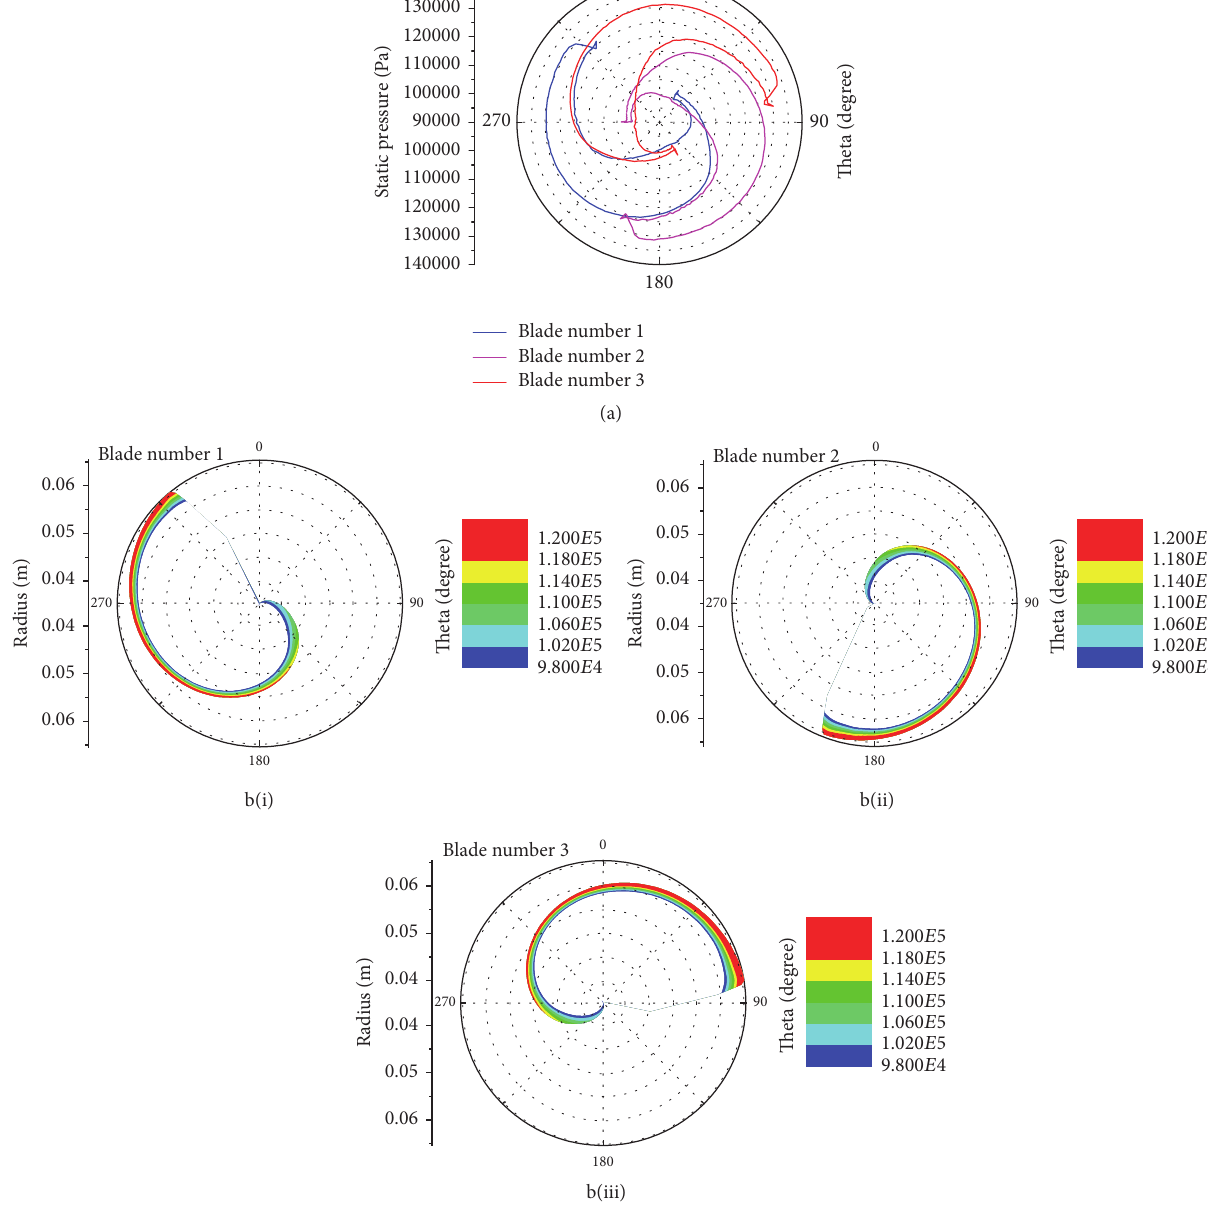
(b) The contour of static pressure distribution on each blade Figure 11: Static pressure distributions and pressure load on the blades of the inducer at 1.0 𝑄 𝑑